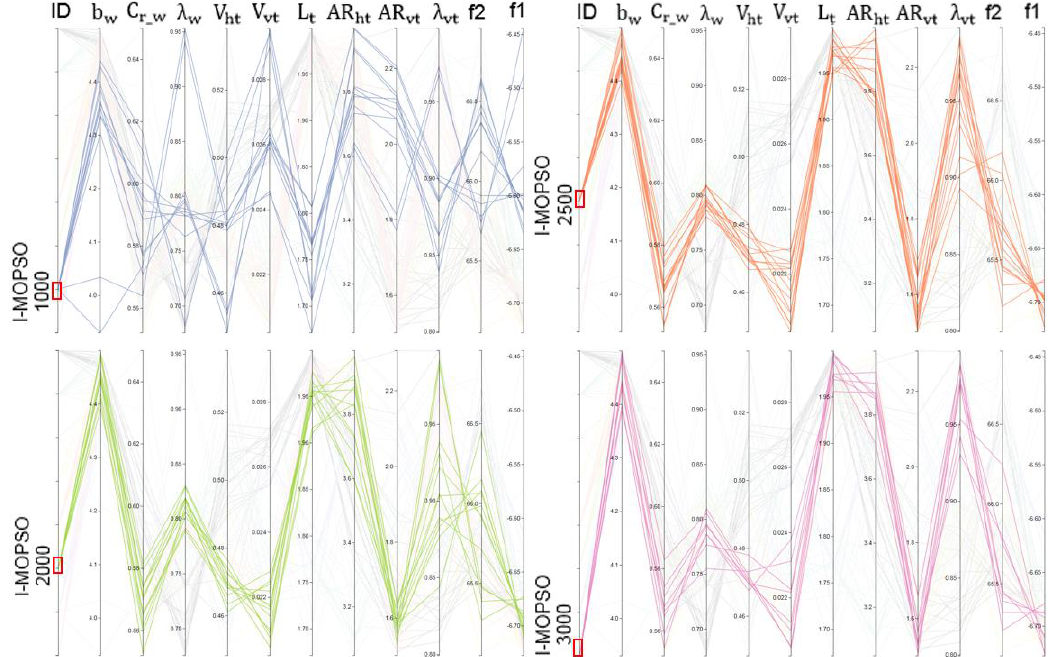
Figure 22. Objective functions as a result of particles with limited variation in the case of interactive